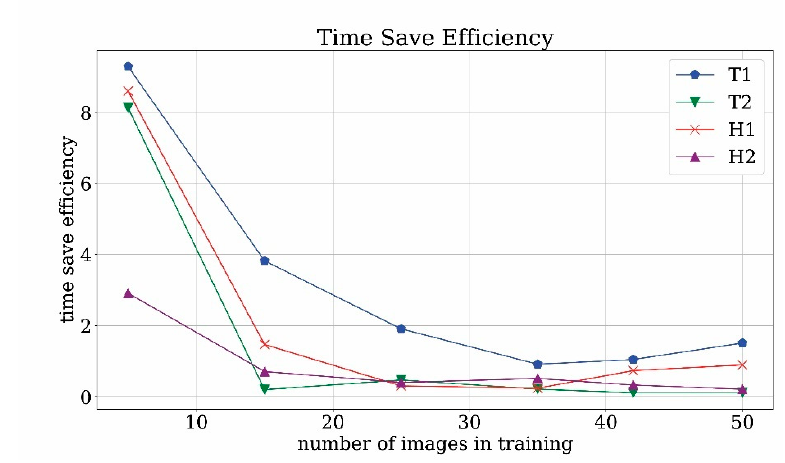
Figure 23. Time Save Efficiency analysis.